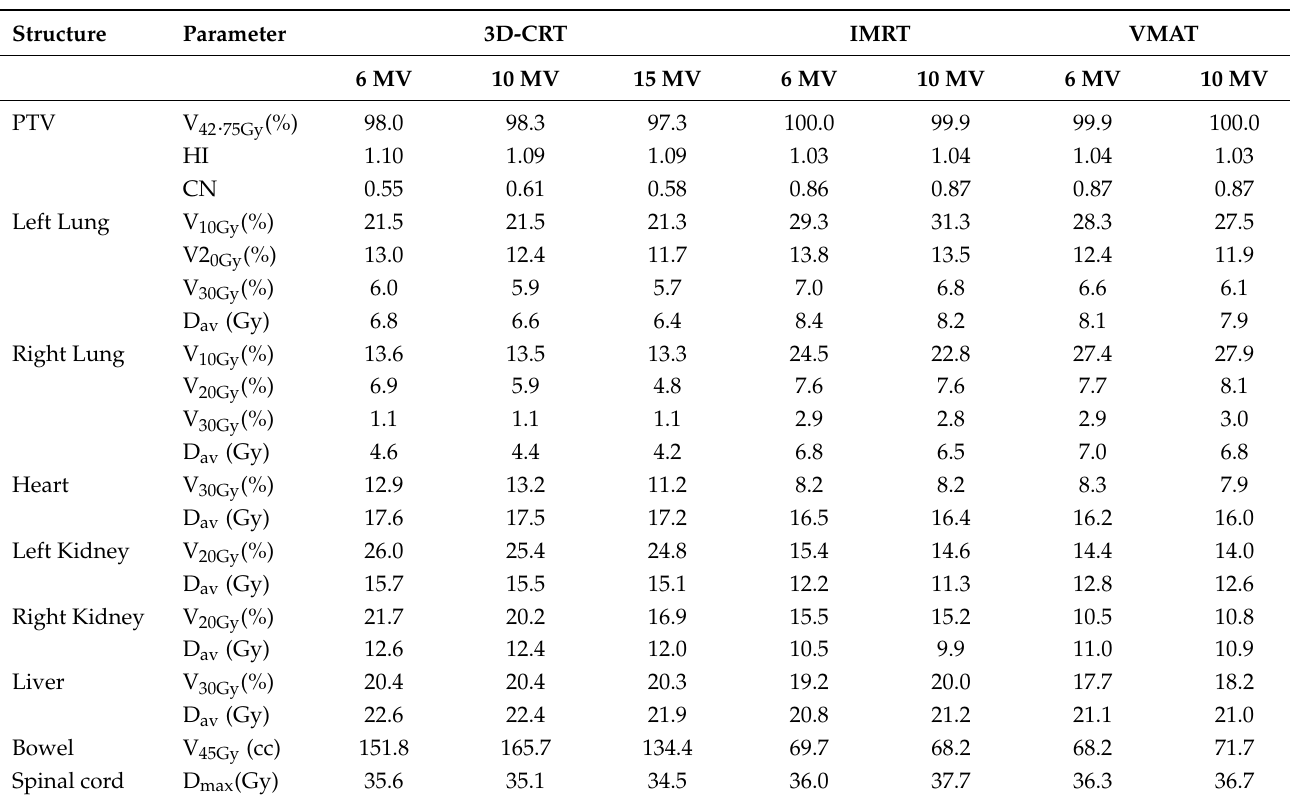
Table 3. Dosimetric parameters for the PTV and OARs derived from radiation therapy plans for gastric cancer on a computational phantom representing an adult male patient.